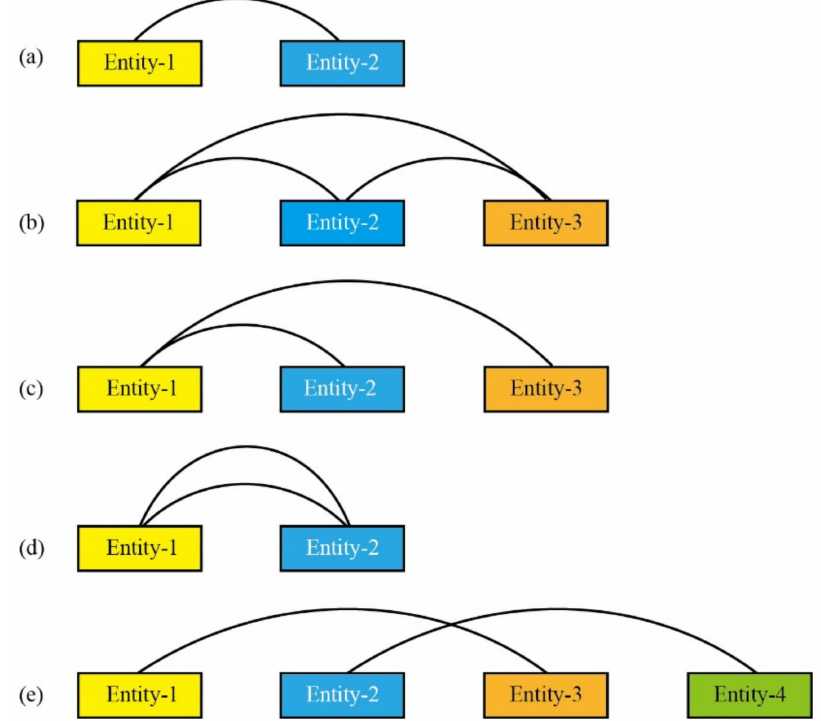
Figure 1. Diagram of the types of relations: ( a ) binary relation; ( b ) N -ary relation; ( c ) single-entity overlapping relation; ( d ) entity pair overlapping relation; ( e ) cross